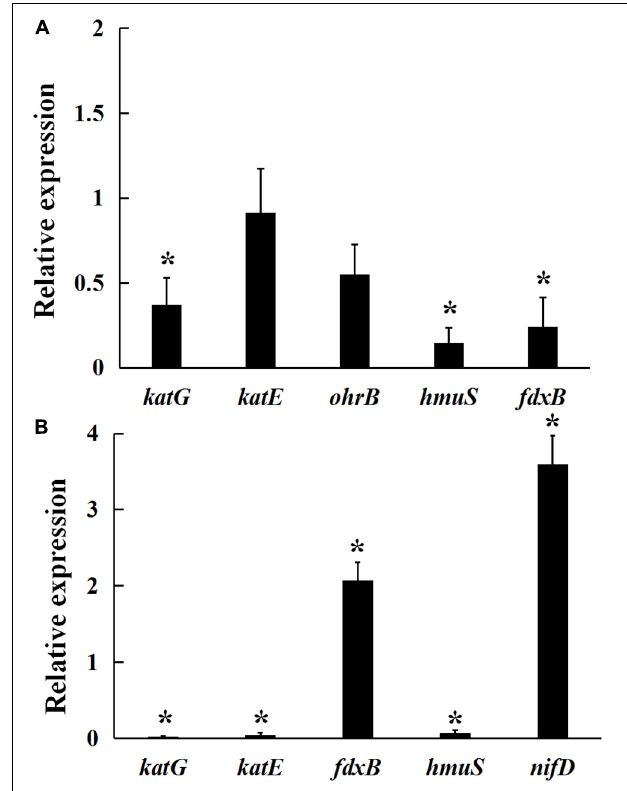
FIGURE 4 | Relative expression of genes involved in hydrogen peroxide stresses (A) and 4-week-nodule bacteroids (B) in gmcA mutant compared with wild-type RL3841 measured by qRT-PCR. The value of relative gene expression in wild-type strain (A) or bacteroid (B) is given to 1.0, and the ratio was the expression level of each gene in mutant RLgmcA vs. in wild-type RL3841. Data are the average of three independent biological samples (each with three technical replicates). Superscript asterisk indicates significant difference in relative expression ( > 2-fold for up-expression or < 2-fold for down-expression, P ≤